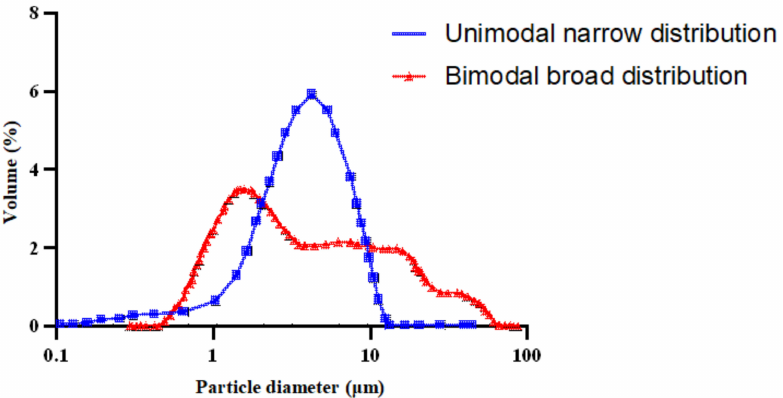
Figure 10. Schematic of bitumen emulsion manufacturing using the HIPR technique [113].